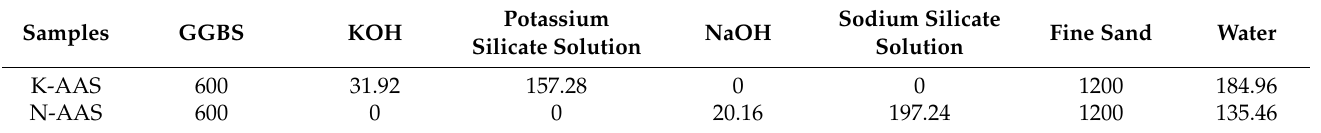
Table 2. Mix proportion of the AAS mortar (g).